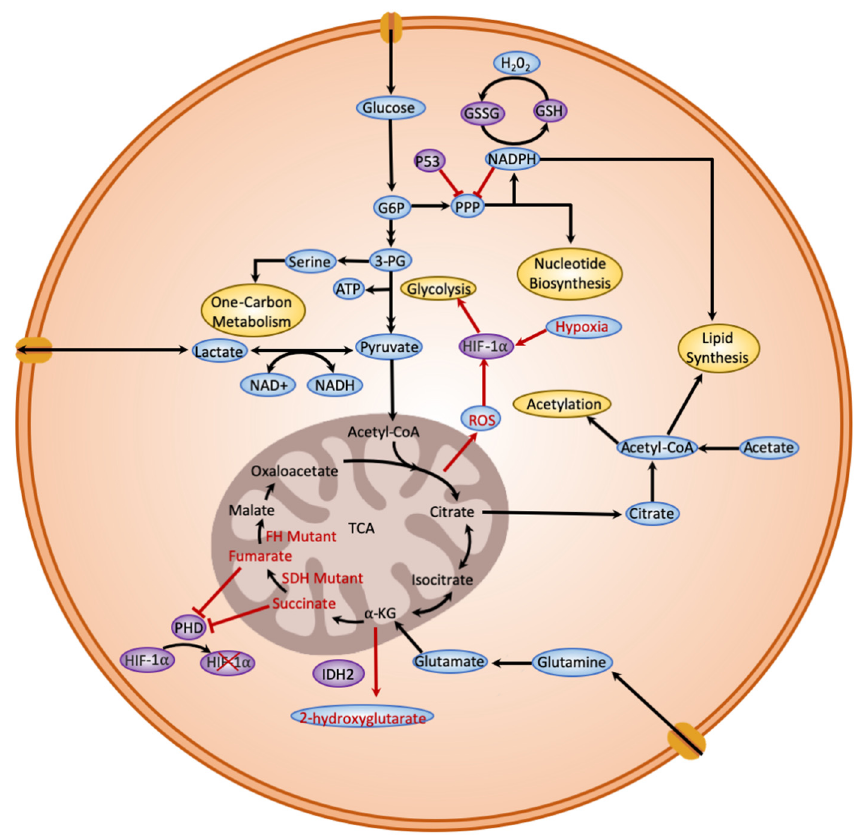
Figure 1. A schematic depicting the Warburg effect in cancer cells. The diagram illustrates the distinct aspects of the Warburg effect in cancer cells, containing glycolysis, pentose pyruvate pathway, lactate fermentation, glutamine metabolism, reactive oxygen species (ROS) generation, Tri-Carboxylic Acid (TCA) cycle, intermediates from the TCA cycle to synthesize lipids, and use of mutations in the TCA cycle (highlighted red) to synthesize oncometabolites. Important metabolic pathways are highlighted in yellow and important enzyme-regulating steps in glycolysis are highlighted in purple. Red lines with blunt ends indicate an inhibitory mode of